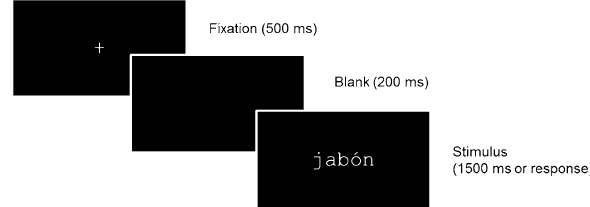
Figure 5. Schematic representation of a trial of Experiment 2 (lexical decision